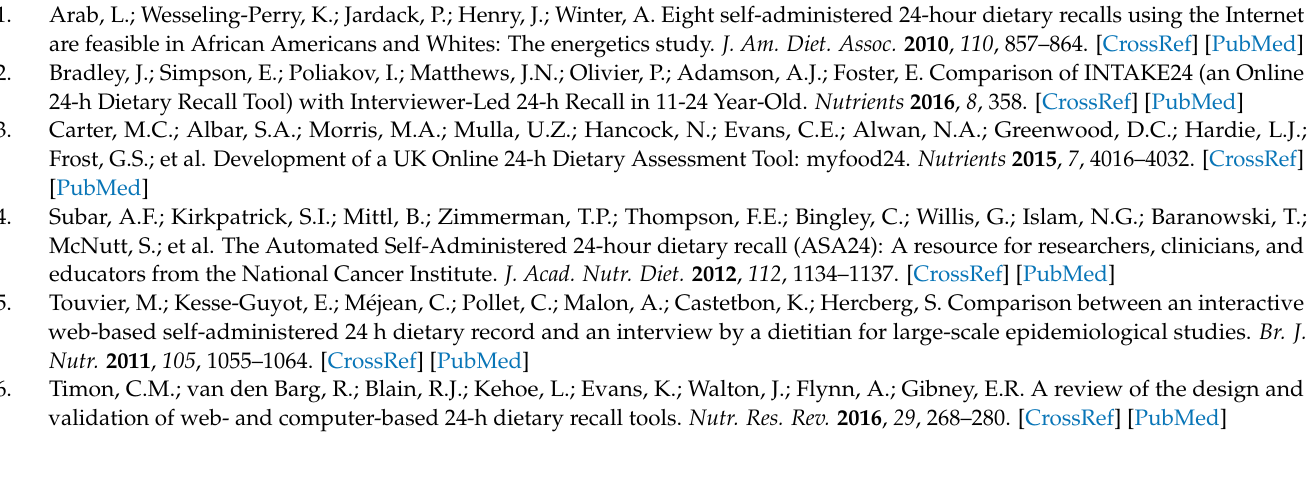
including nutritional supplements using the extensive ( n = 5933) and rationalised ( n = 2481) NDB; Figure S1a. Respondents (%) moving categories of nutrient adequacy for total fat recommendation (20–35 %TE) using the extensive and rationalised NDB); File S2: Food matching process, yogurt example. (Table S2a. Determining three key nutrients, example yogurt; Table S2b. Comparison of the key nutrient content of two yogurt codes; Figure S2a. The screen of Diet In Nutrients Out (DINO) used for the comparison of foods in pairs using the cut-offs, key nutrients and the average amount of foods consumed in NDNS survey year 2017); File S3: Matching sandwiches